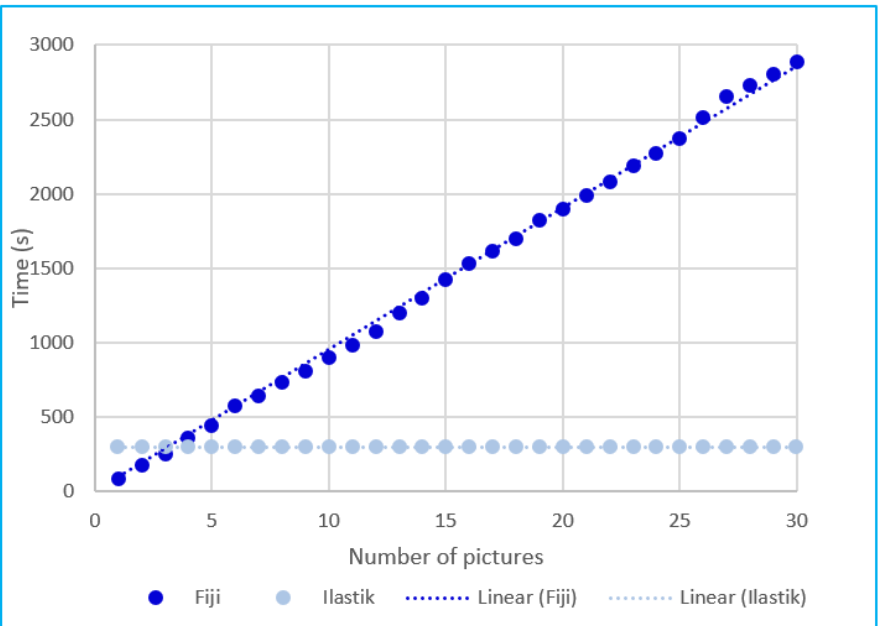
Figure 4. The time required by the operator to analyse the area occupied by fronds of Lemnaceae. The dark blue line represents the time required by the operator by employing the Fiji software; the light blue line represents the time requirements with the ilastik ® software. The x-axis represents the number of pictures; the y-axis represents the time requirement per picture.